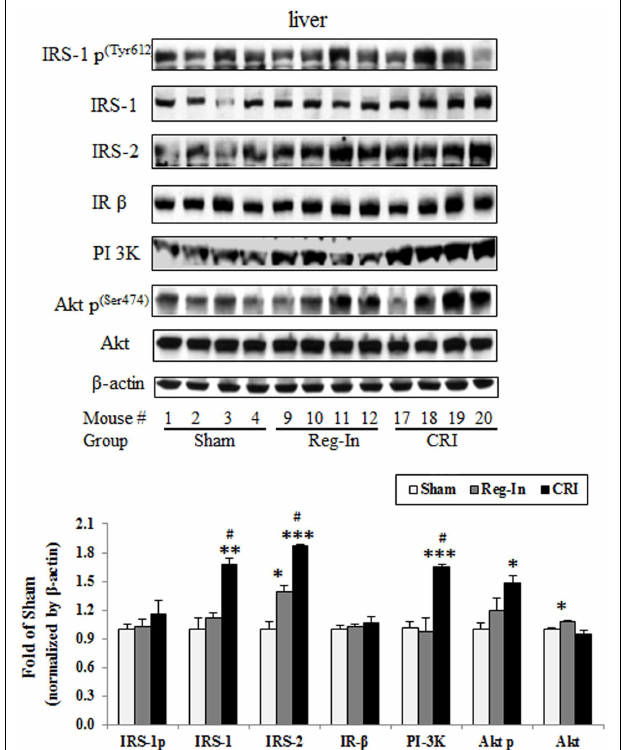
FIGURE 3 | Hepatic insulin signaling protein abundance in KKAy mice treated with or without Reg-In and CRI . Liver lysates were subjected SDS-PAGE and transferred to nitrocellulose membranes, interesting proteins of insulin signaling were detected with specific antibodies against IRS-1, IRS-2, and so on showed in the legends. Results were normalized by β -actin. Data were presented as mean ± SEM ( n = 8/group). * P < 0.05, ** P < 0.01, and *** P < 0.001, CRI or Reg-In group vs. Sham group, respectively. # P < 0.05, CRI vs.